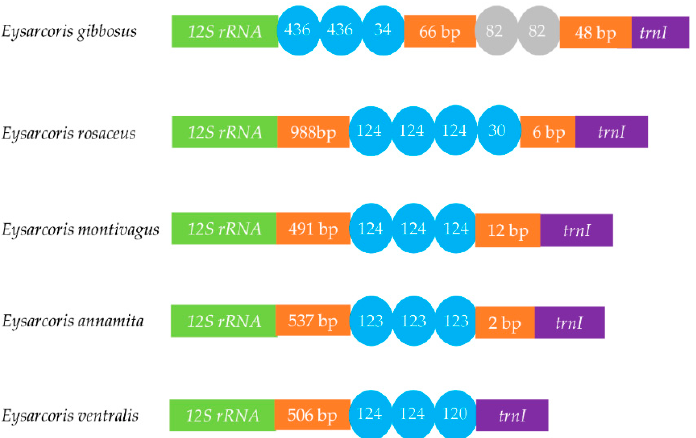
Figure 7. Organization of the control region in the five mitochondrial genomes. The tandem repeats are shown by the blue or gray oval with repeat length inside. Non-repeat regions are shown by orange box with sequence length inside.